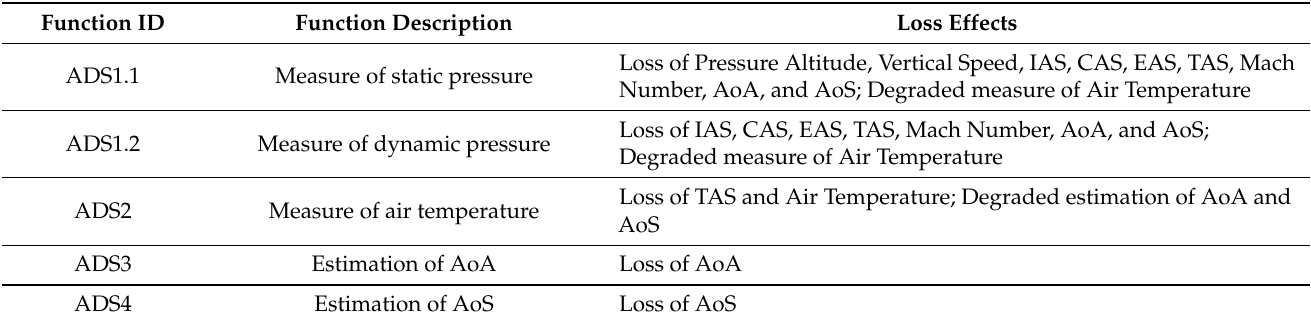
Table 2. ADS function requirements and loss effects.